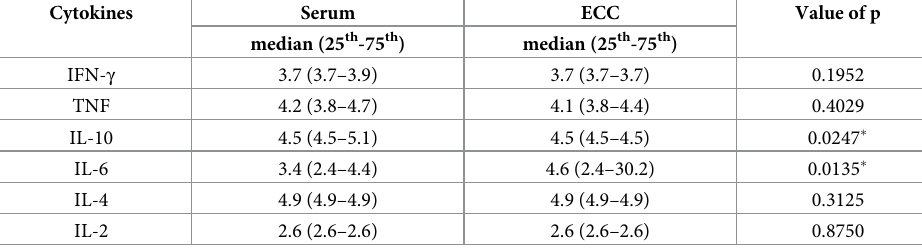
Note: The results are expressed as the median and interquartile range (25 th -75 th ). Wilcoxon signed-rank test was performed. Statistical significance was set at p < 0.05. ECC exfoliated cervical cells.